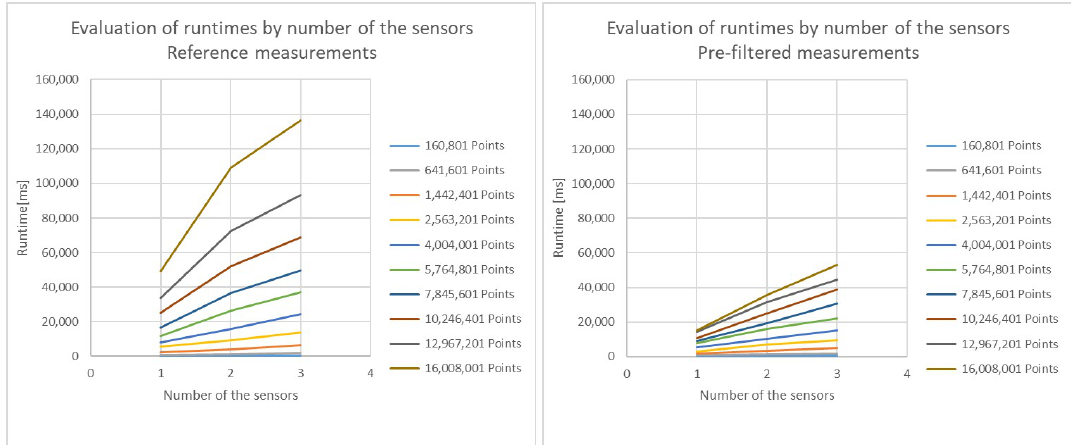
Figure 8. Evaluation of the runtimes for a different number of sensors for various evaluated areas. On the left hand side, the reference measurement is visible and on the right hand side is the pre-filtered one with the same